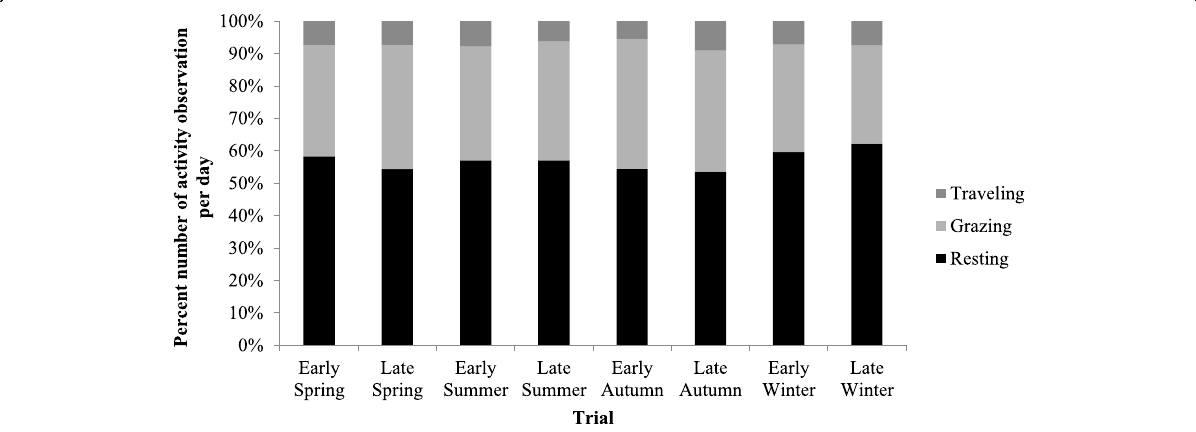
Fig. 3 Percentage and standard error of activity observations per day of a free-ranging cattle herd ( N = 11) during eight trials of 21 days in a semi-arid rangeland. Activity observations occurred at a 5-min interval throughout 24 h